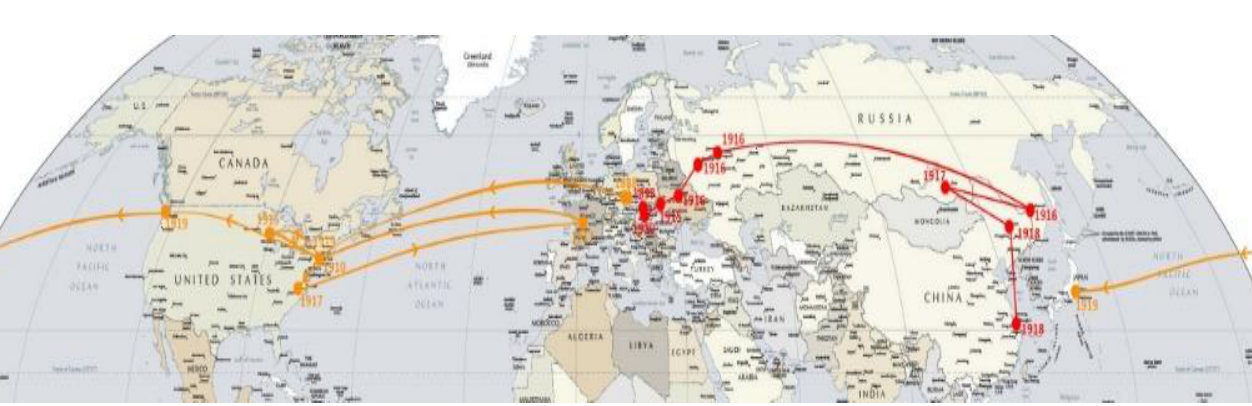
Figure 1. Compa rison between Hudec and Raymond’s trajectory from Europe to Eastern Asia Figure 1. Comparison between Hudec and Raymond’s trajectory from Europe to Eastern Asia (Hudec’s trajectory in red, Raymond’s trajectory in (Hudec’s trajectory in red, Raymond’s trajectory in orange).